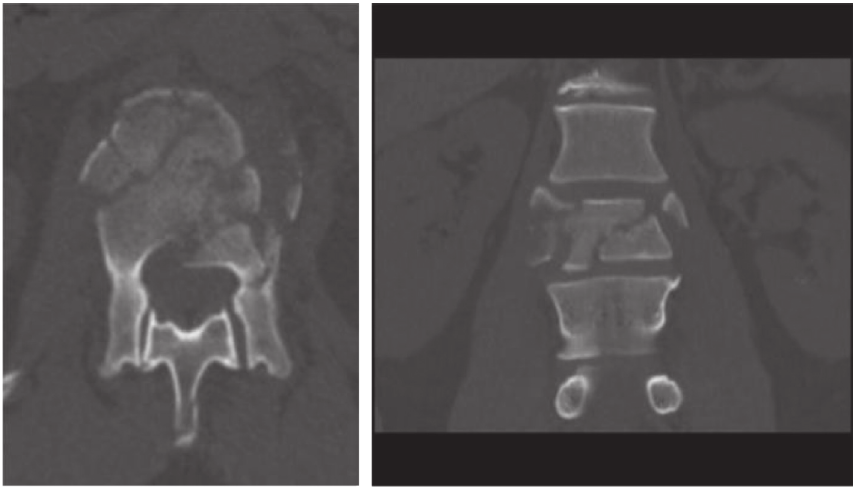
Figure 1: Axial and coronal CT scan of L1 burst fracture after a snowmobile accident.